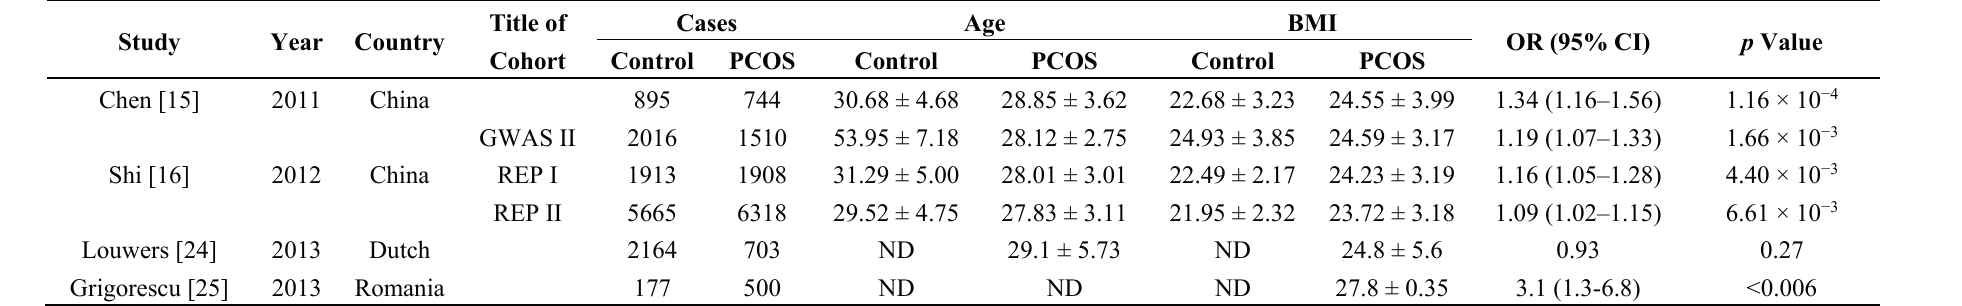
Table 5. Cohort characteristics and odds ratios (ORs) of the INSR rs2059807